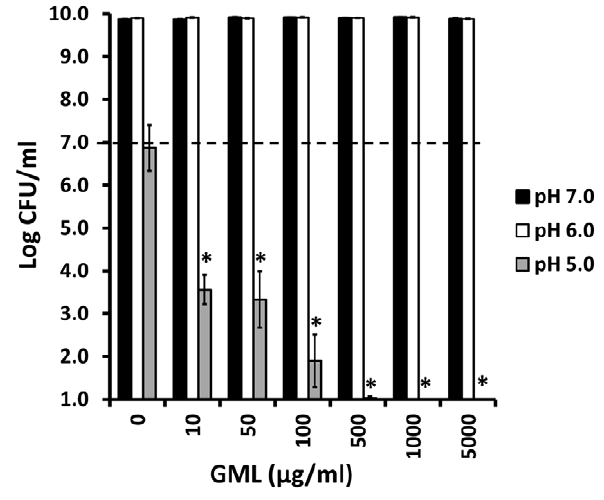
Figure 13. Effect of pH on GML activity against Pseudomonas aeruginosa. Todd Hewitt broth was buffered to pH 7.0, 6.0, and 5.0. Susceptibility of Pseudomonas aeruginosa PA01 to GML at the indicated pH was measured in 24 hour assays. CFUs/ml were determined by plate counts. * indicates sample means differ significantly from the no GML control at p , 0.001. Dashed line indicates the inoculum